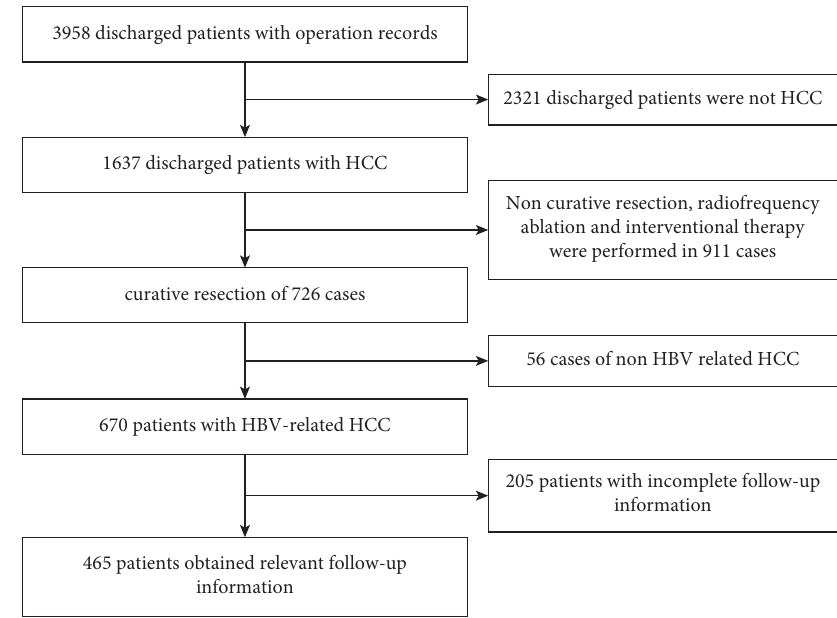
Figure 1: Patients’ selection process at the First Affiliated Hospital of